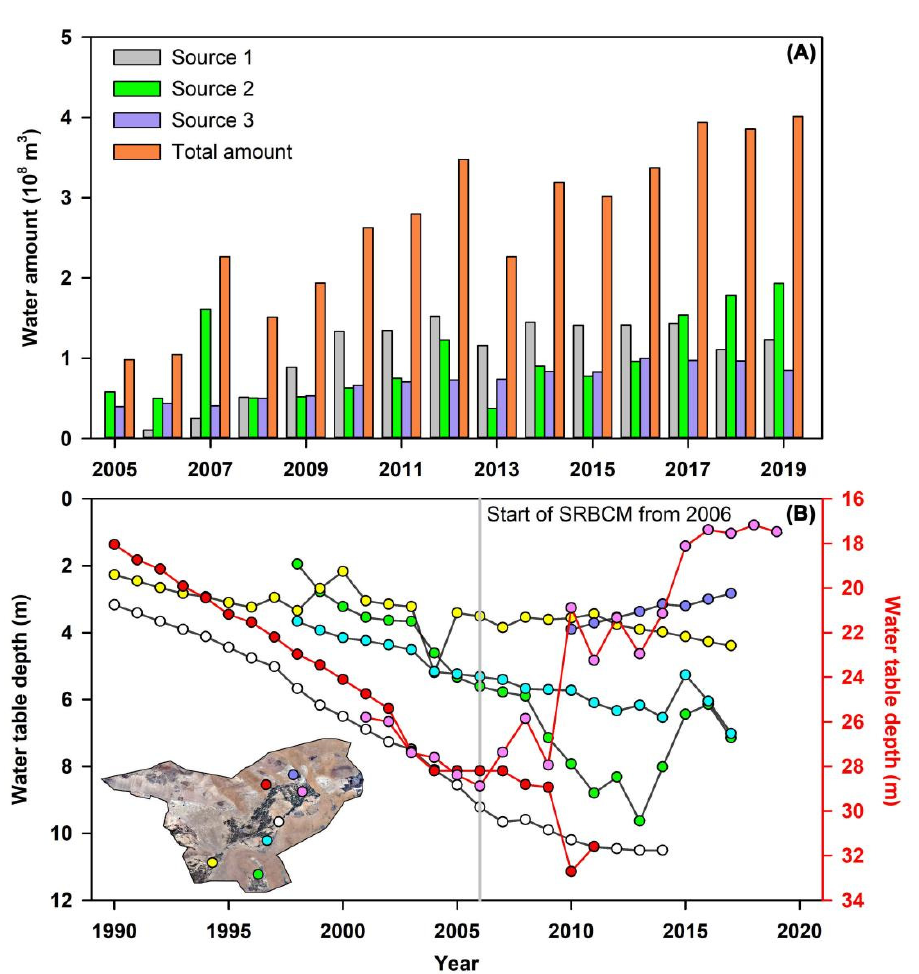
Figure 13. Variation in the total water amount in the lower reaches since 2005 ( A ) and annual water table depth since 1990 ( B ). Note: SRBCM is the Shiyang River Basin Comprehensive Management, which started in 2006 in order to restore the rapidly degrading natural ecosystems due to groundwater overdraft. The SRBCM relieved the water shortage problem in the lower reaches mainly by enhancing the direct water transfer amount from the Xiying Reservoir at the upper reaches of the Shiyang River (Source 1), the inter-basin water transfer amount from the Yellow River based on the Jingtaichuan Pumping Irrigation Engineering Project (Source 2), and the runoff in natural river course (Sources 3).